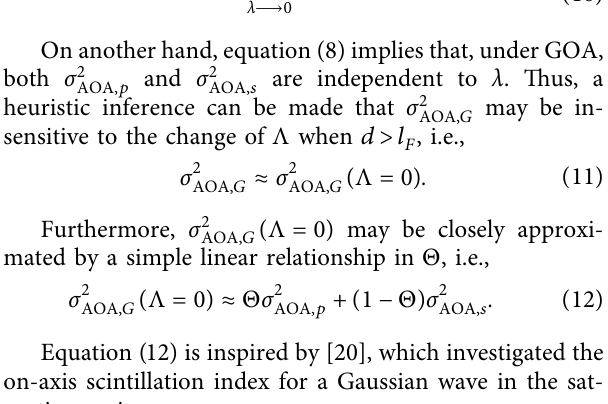
Figure 1: Validation of equation (12).